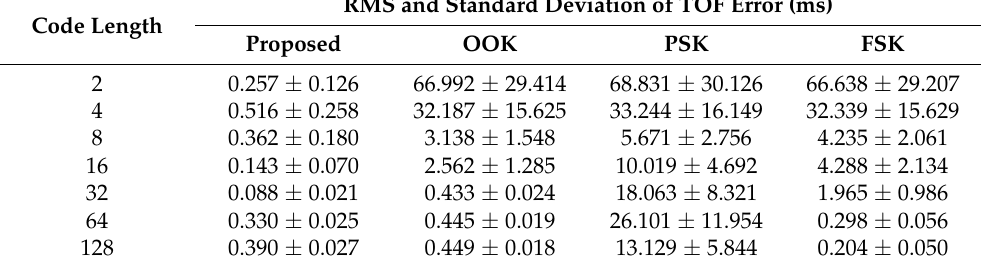
Table 2. Comparison of RMS TOF error according to ID length of the proposed method and the existing method.